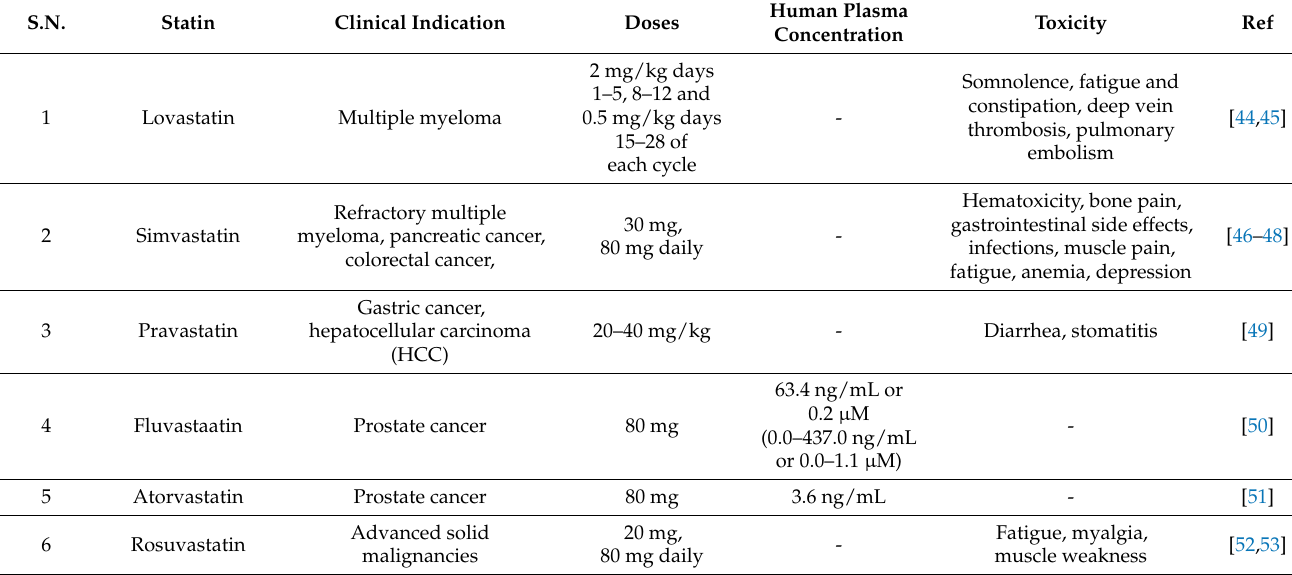
Clinical trials showing the use of statins with their clinical indications, toxicities, doses, and human plasma